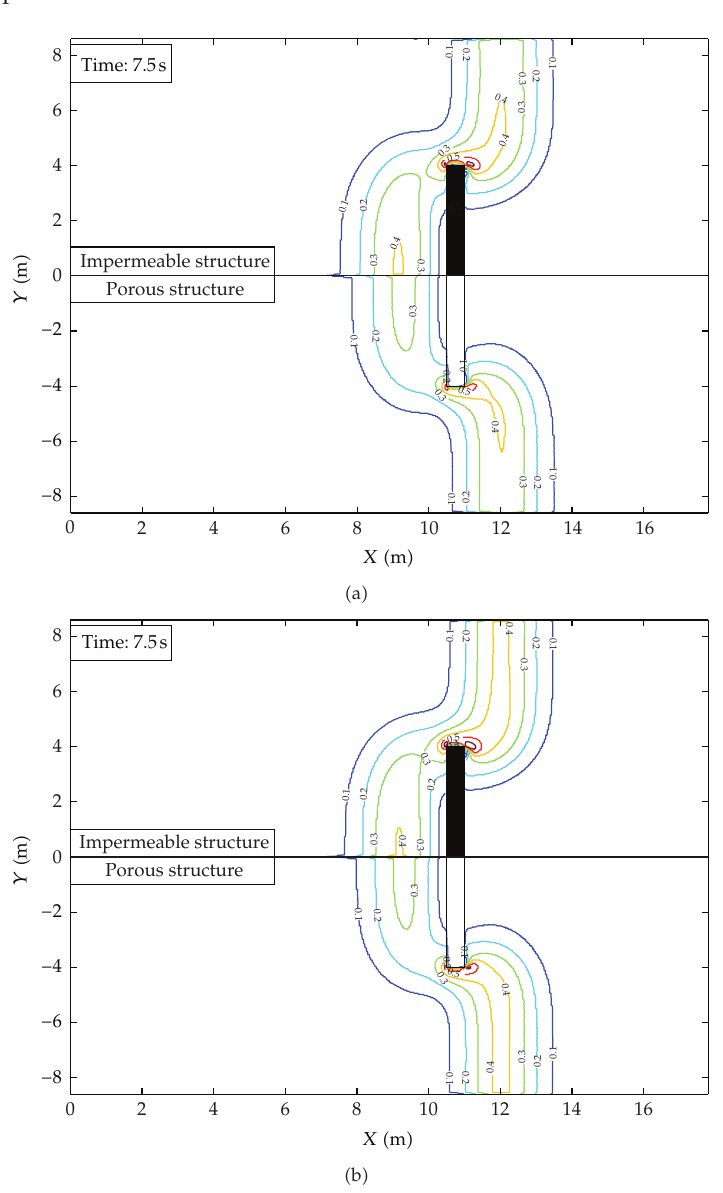
Figure 9: Velocity module isolines for the impermeable and porous structure under the action of the solitary wave case of height H (cid:7) 9cm and water depth h (cid:7) 40cm. Data in m / s. Upper figure slice at plane z (cid:7) 0 . 02m. Lower figure slice at plane z (cid:7) 0 . 2m, part